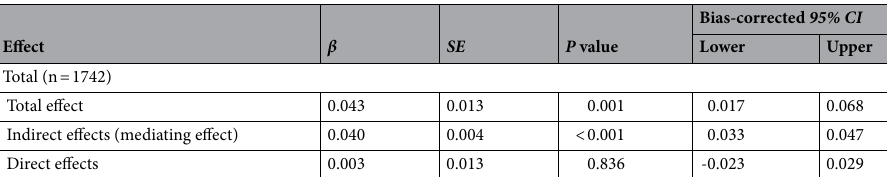
Table 4. The Mediating effect of depression on the relationship between sleep duration and cognitive function. SE standard error, 95% CI 95% confident interval. All the analysis under controlling of age, gender, education, marital status, residency, smoking, drinking, BMI, hypertension, dyslipidemia, and diabetes or high blood